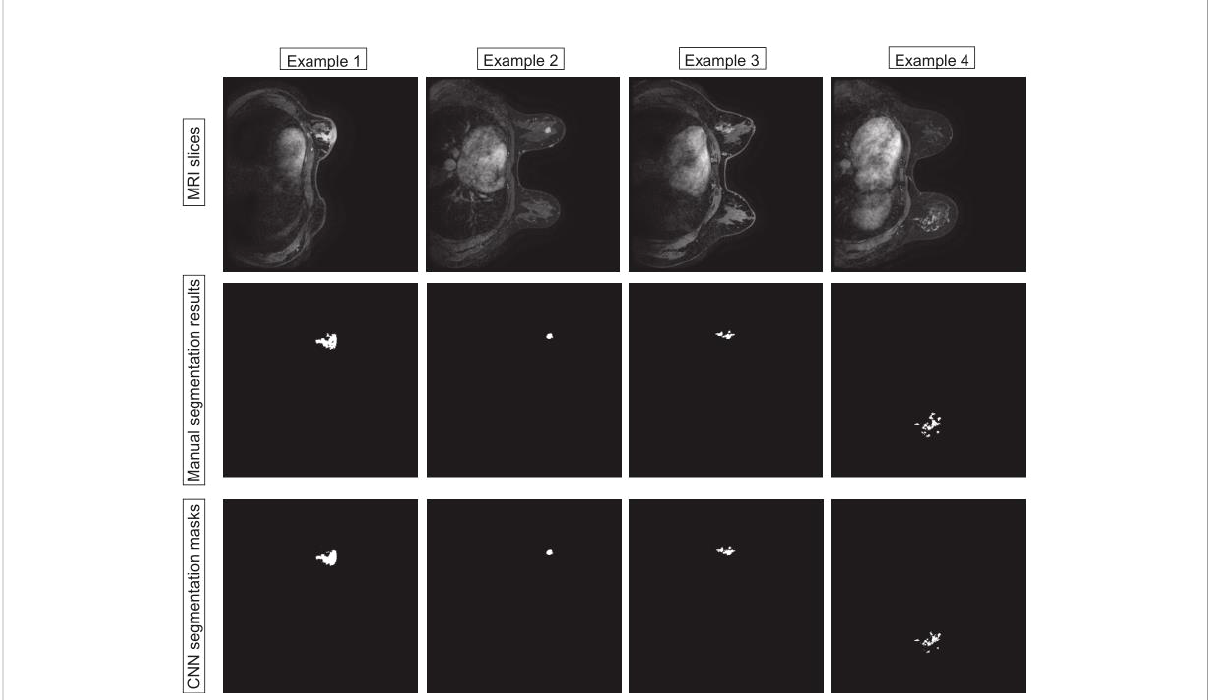
FIGURE 4 Examples of the 2D breast lesion segmentation results. Examples 1 and 2: the fi broglandular structure was dense and the lesions showed mass- like enhancement with an irregular lobulated pattern and hairy margins. Examples 3 and 4: the lesions showed non-mass-like enhancement with a distribution characterized by lobular segments and internal enhancement characterized by inhomogeneous string – ring-like and patch- like features,